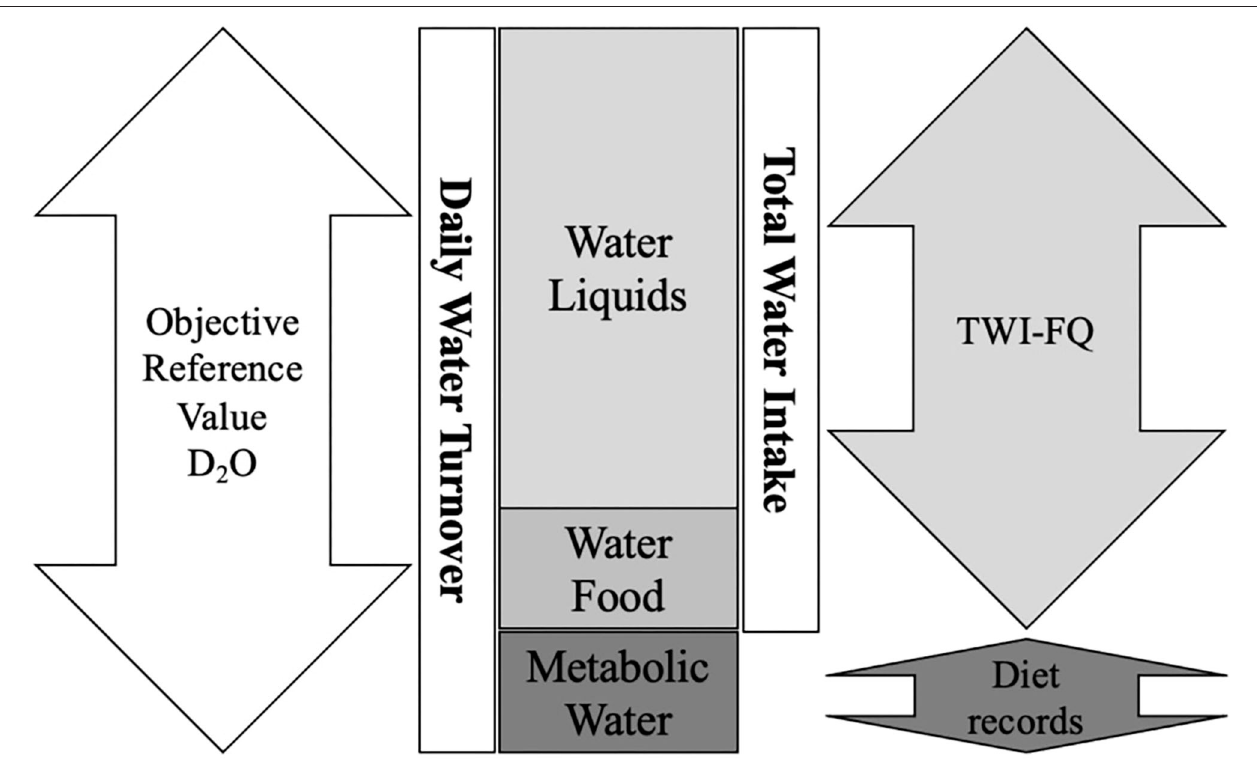
FIGURE 1 | Estimation of total water intake using deuterium oxide dilution method and the total water intake frequency questionnaire. D 2 O, deuterium oxide; TWI-FQ, total water intake frequency questionnaire.